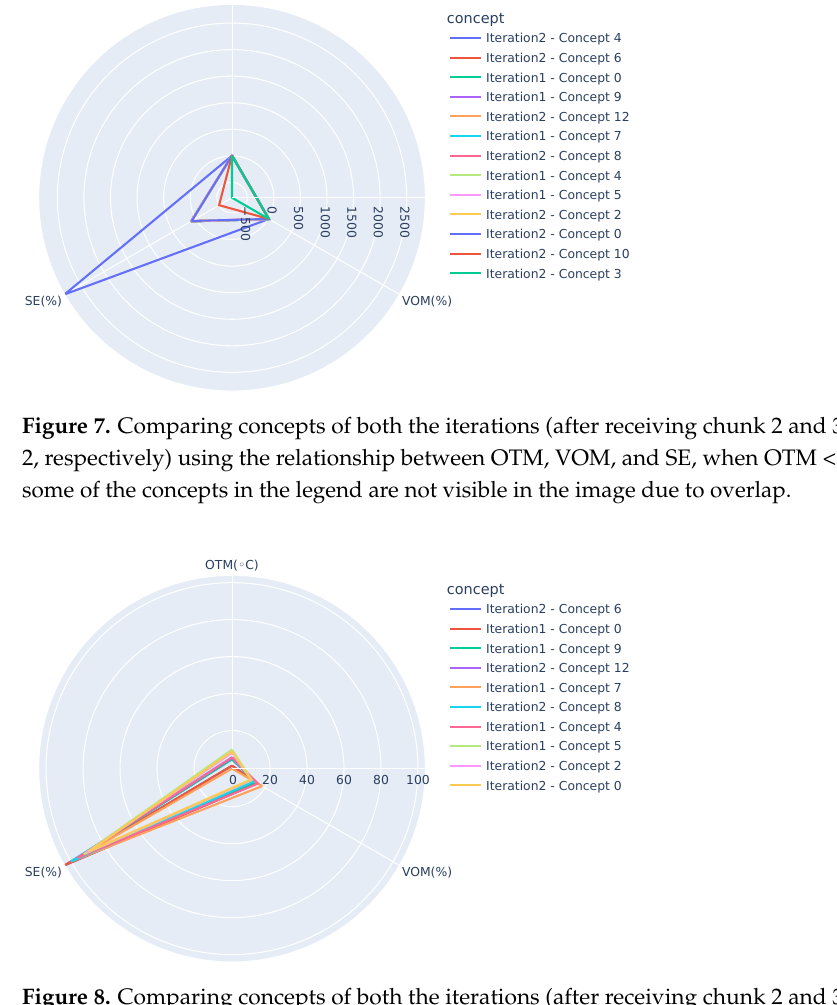
Figure 8. Comparing concepts of both the iterations (after receiving chunk 2 and 3, Iteration 1 and 2, respectively) using the relationship between OTM, VOM, and SE, when OTM < 10 ◦ C and after removing deviating concepts 3, 4, and 10 of iteration 2. Note that some of the concepts in the legend are not visible in the image due to